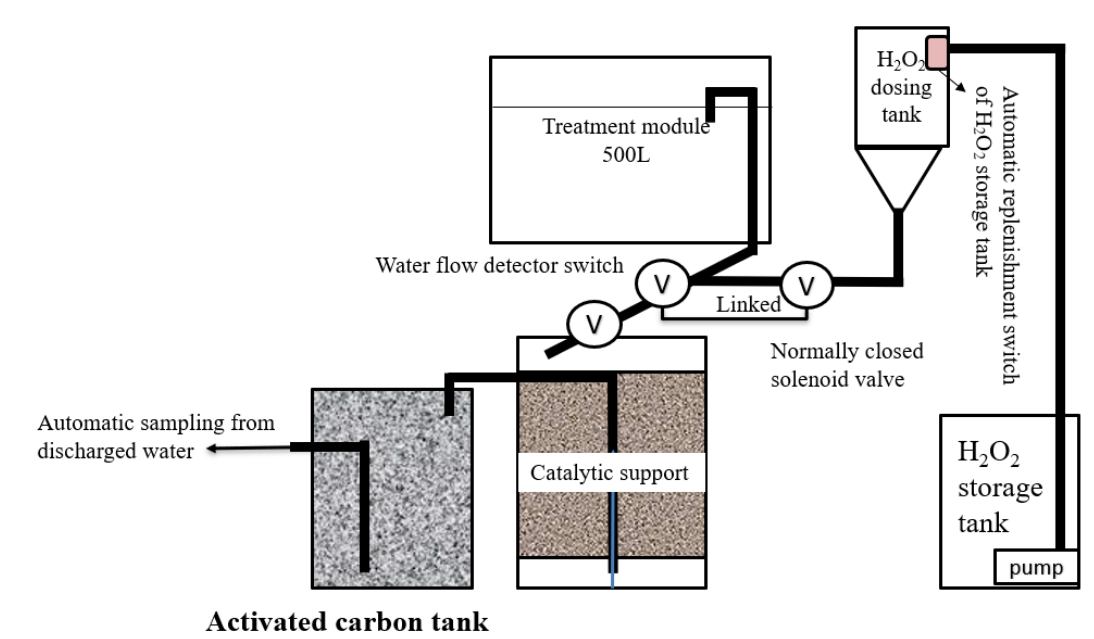
Figure 3. Schematic diagram of the test module of low-energy siphon treatment system.